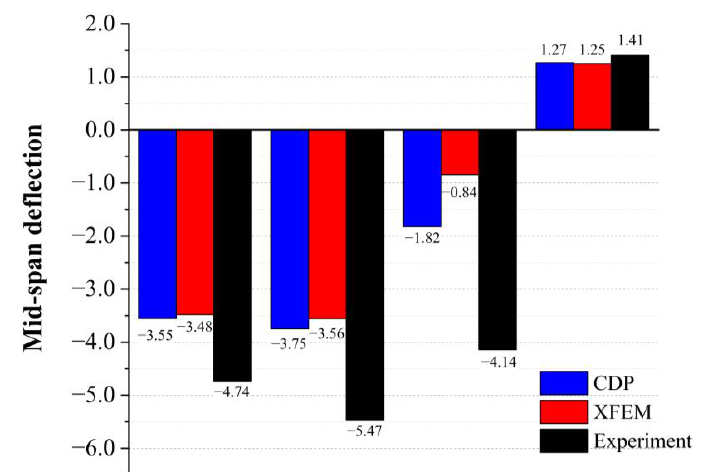
Figure 24. Midspan